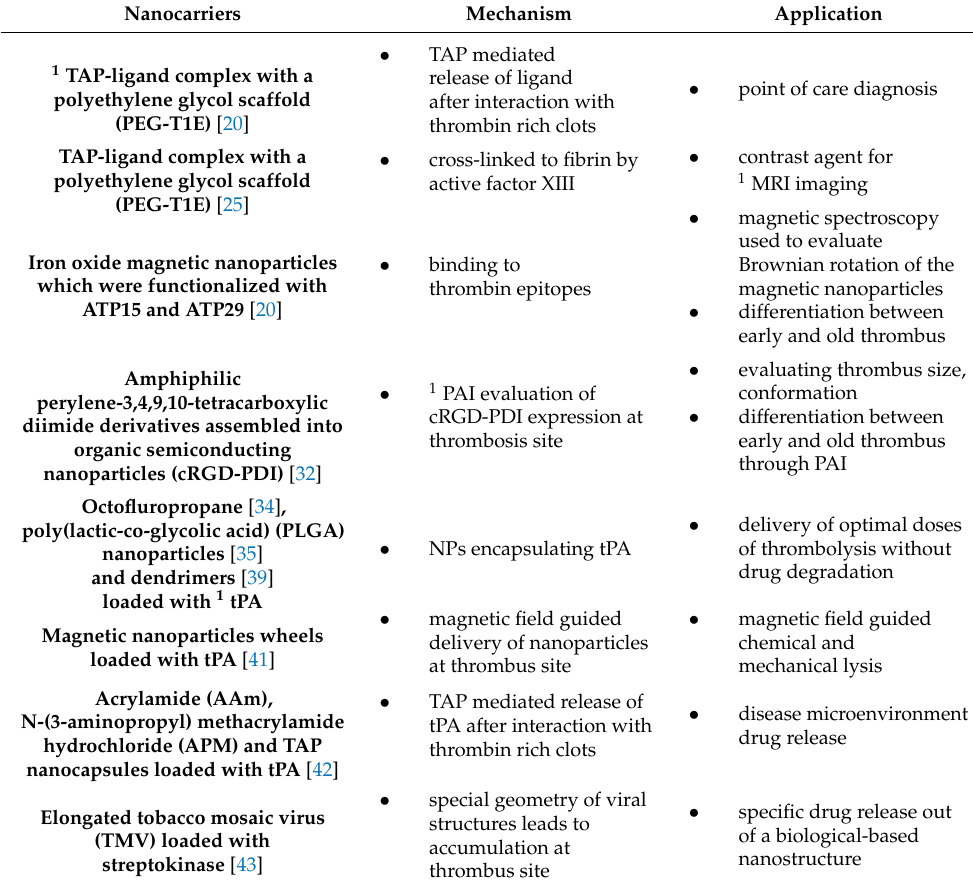
Table 1. Nanocarriers for management of